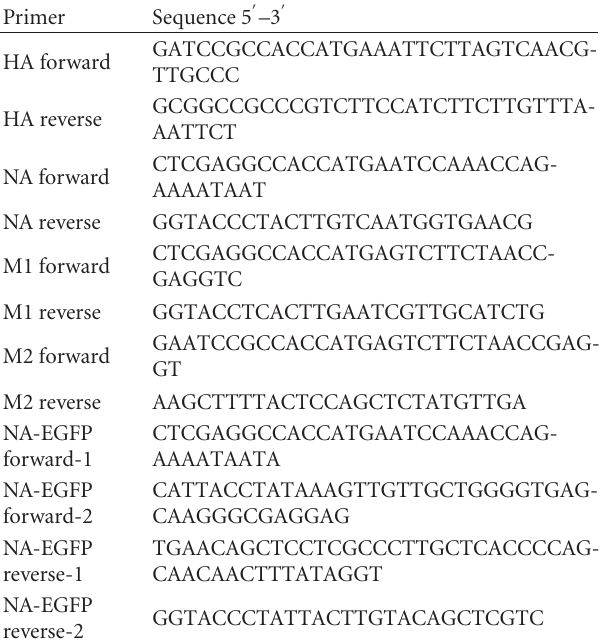
Table 1: Primer sequence used in pFastbac Dual vector construc-